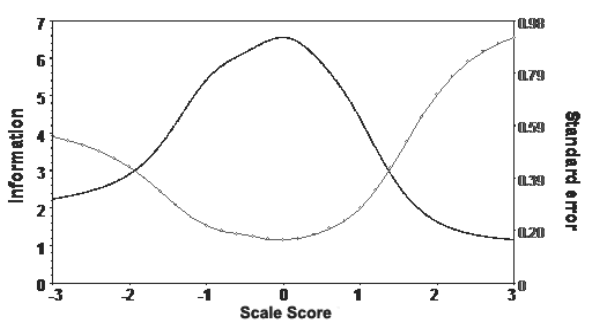
Figure 2 – Item Information and measurement error curve (1st